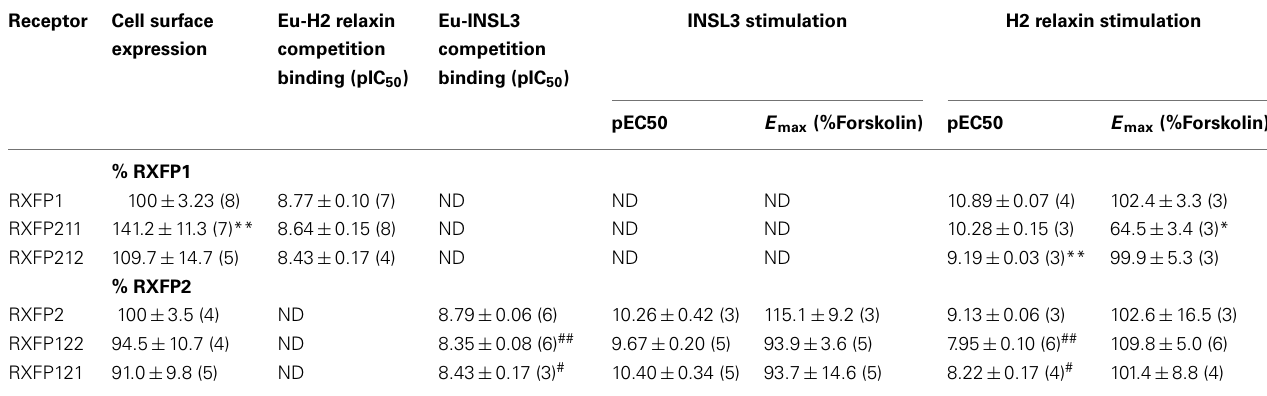
Table 2 | Pooled binding affinity (pIC 50 ), cell surface expression and cAMP activity (pEC 50 and E max ) data for chimeric receptors in comparison to RXFP1 and RXFP2.